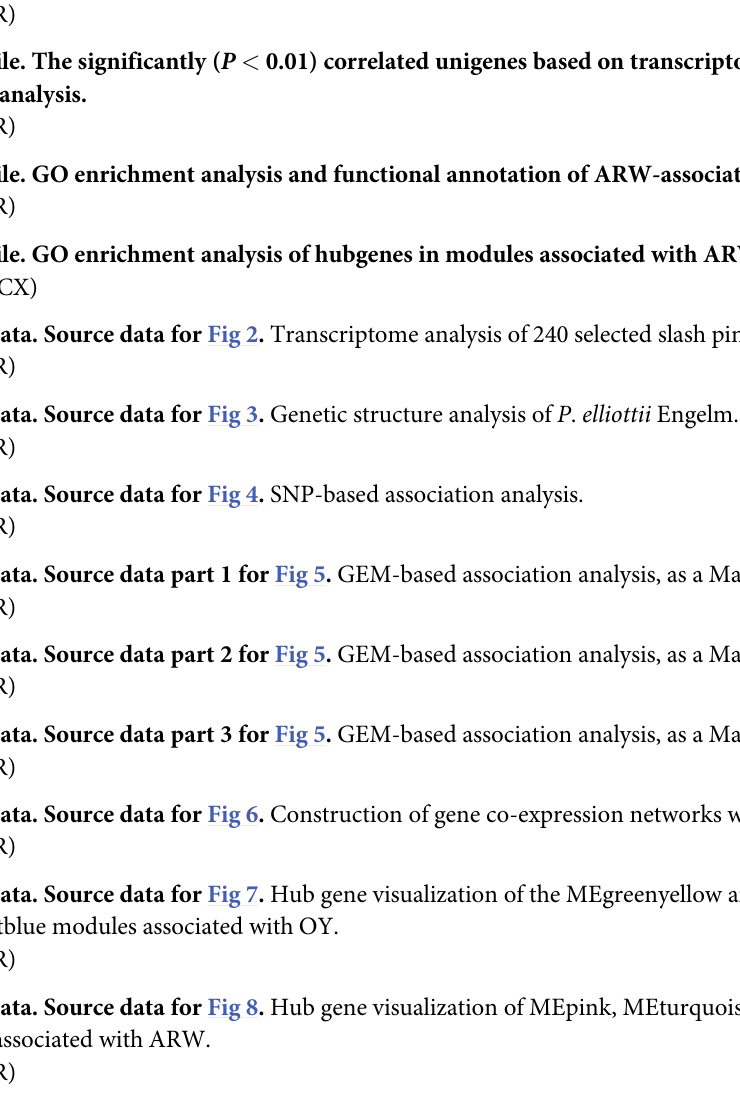
S7 Table. Genetic diversity parameters at the group level inferred by ADMIXTURE. (DOCX) S8 Table. Hubgenes associated with OY in MEgreenyellow and MEmidnightblue module respectively. S9 Table. Functional annotation of 4 genes encoding HSP family members and 1 gene encoding